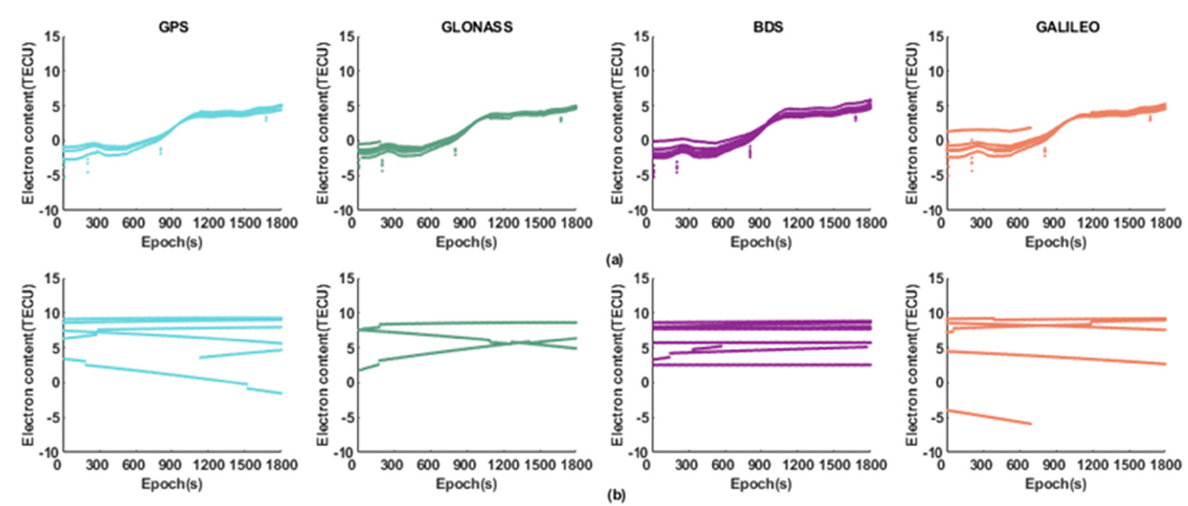
Figure 6. Electron content error at the pierce point. ( a ) Regional ionospheric model; ( b ) Klobuchar model.